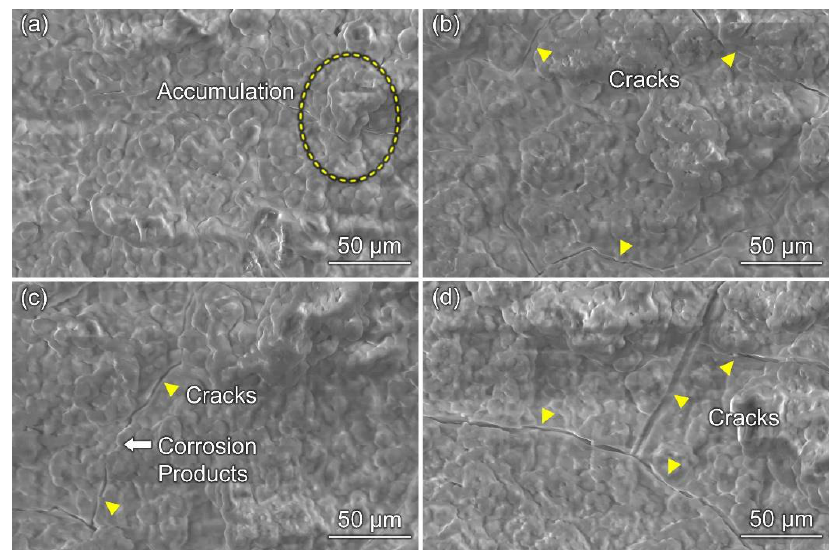
Figure 10. Morphology of samples after immersion: ( a ) 5 days; ( b ) 10 days; ( c ) 15 days; ( d ) 20 days.